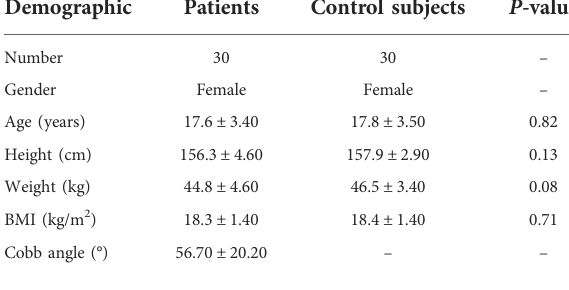
TABLE 1 Demographic data of AIS patients and